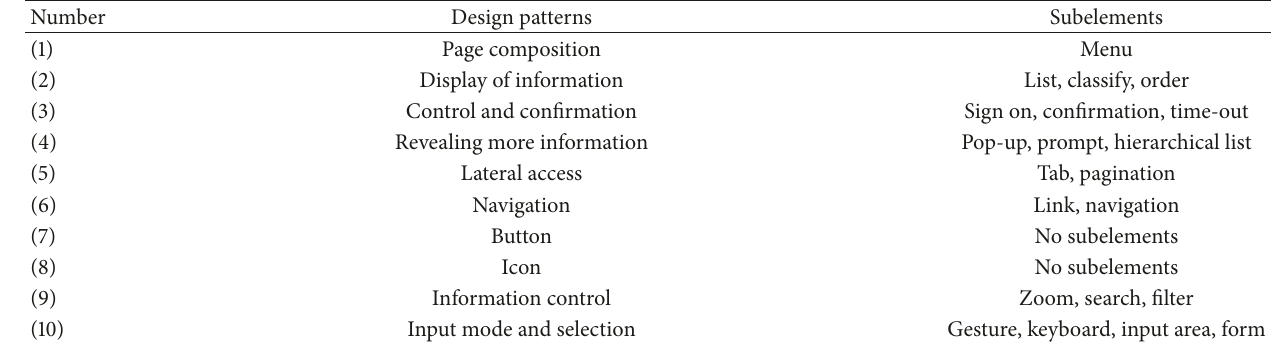
Table 2: Design patterns and subelements.